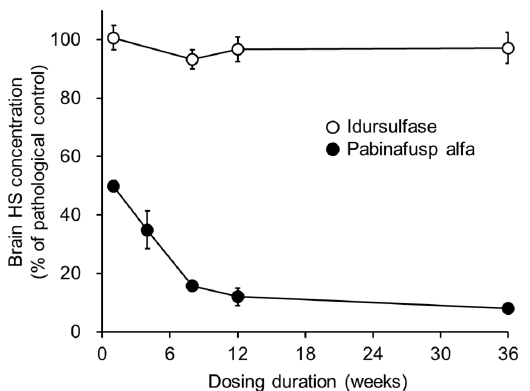
Figure 2. Substrate reducing efficacy of pabinafusp alfa in the brain of MPS II mice. Pabinafusp alfa was intravenously administered to mice at a dose of 2 mg/kg once per week for 1, 4, 8, 12, or 36 weeks. The dose of idursulfase was 0.5 mg/kg/week. Data are from independent experiments (mean with S.D. bars, n =